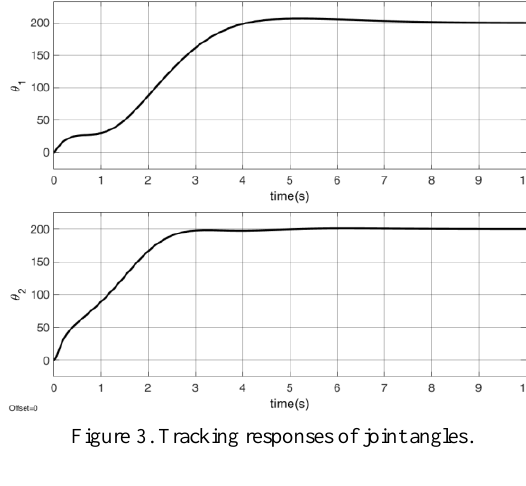
Figure 3. Tracking responses of joint angles.